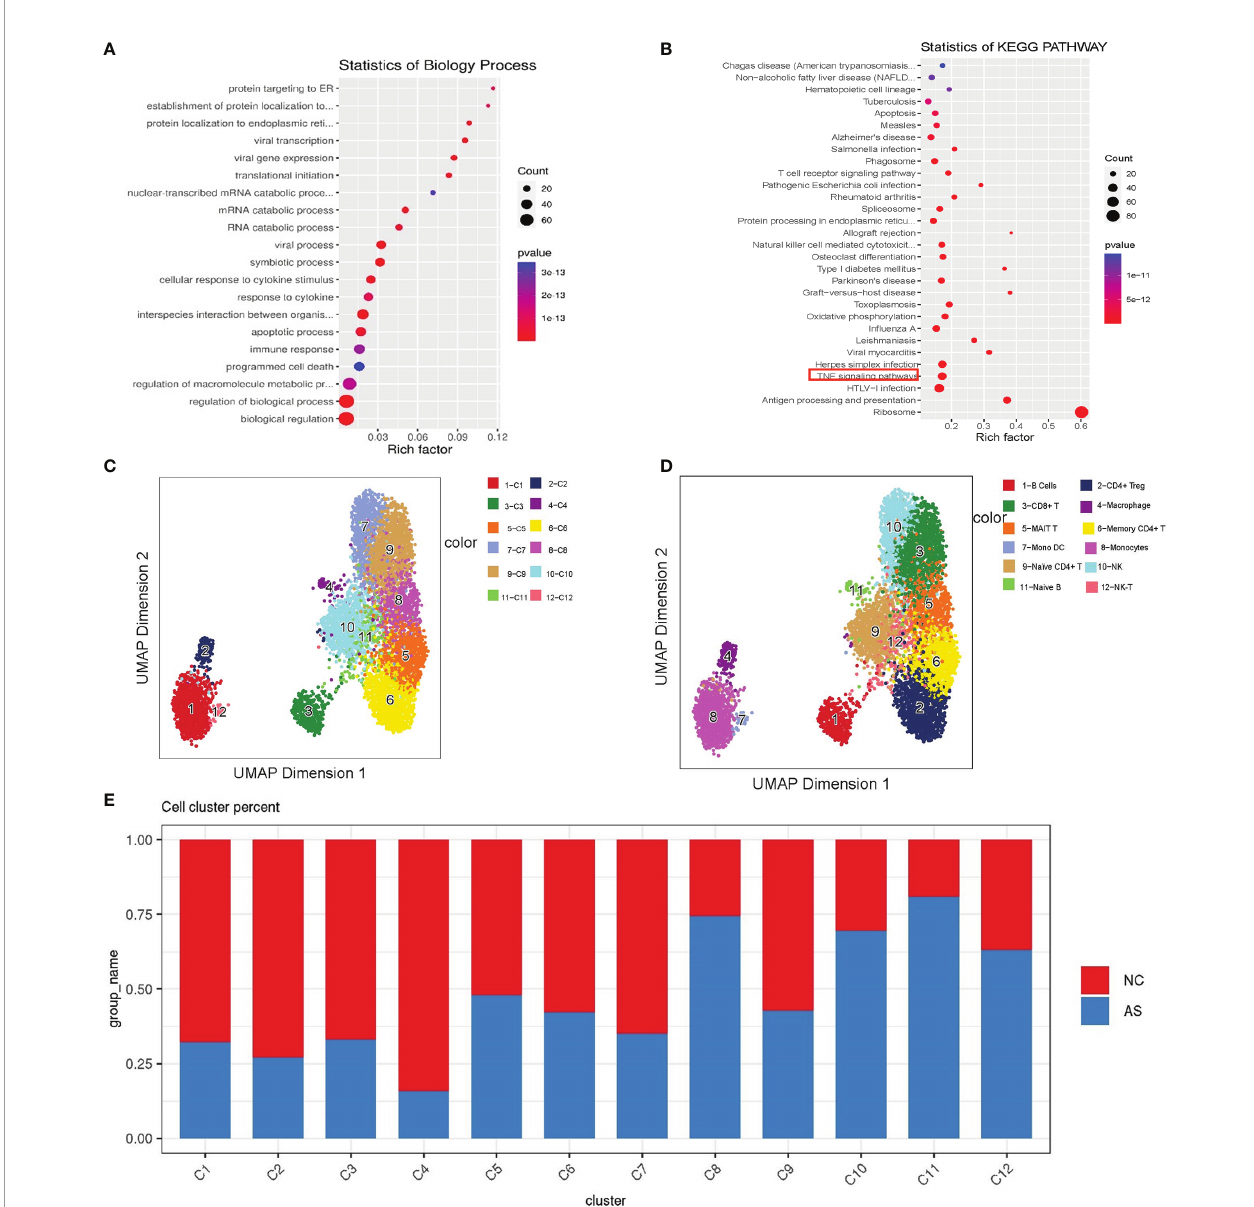
FIGURE 4 | Single-cell analysis of CD8+T cell. (A) GO term analysis for biological processes of differentially differential genes between the AS-PBMC and NC-PBMC scRNA-seq libraries in CD8 +T cells (p < 0.05); (B) KEGG pathway analysis of differentially differential genes between the AS-PBMC and NC-PBMC scRNA-seq libraries in CD8 +T cells (p <0.05). The red border indicates the TNF signaling pathway; (C) A UMAP plot showing 12clusters through SCATAC-seq; (D) A UMAP plot showing 12 leukocytic clusters corresponding to 12 cell types according to known cell marker genes through SCATAC-seq; (E) Cell abundance in clusters across the AS-PBMC and NC-PBMC